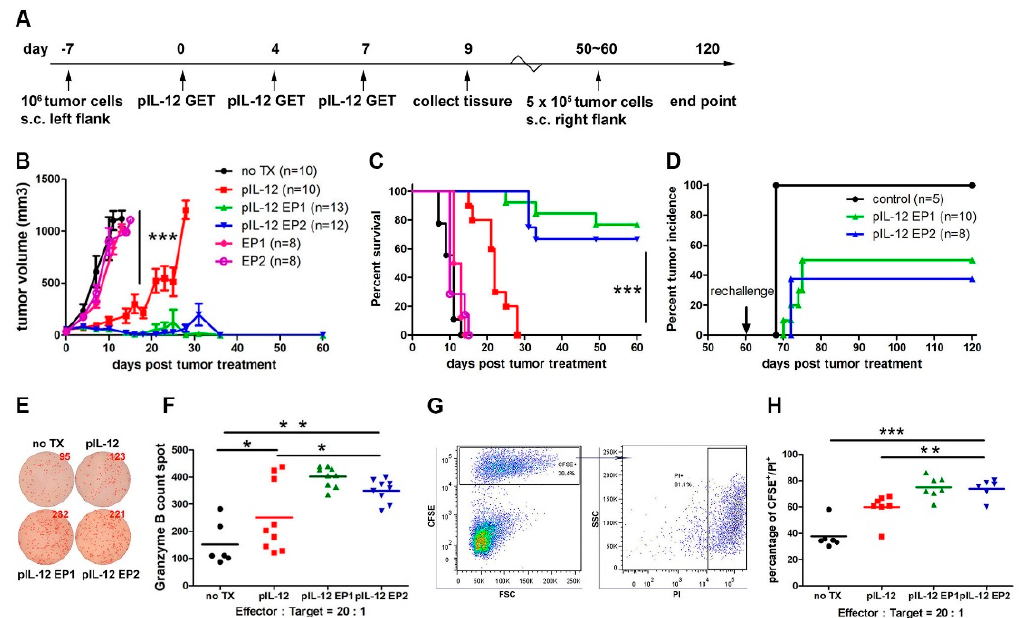
Figure 1. Antitumor efficacy in B16F10 tumor-bearing mice treated with IL-12 plasmid delivered by in vivo electroporation (pIL-12 GET) and protective immunity against tumor rechallenge. ( A ) Experimental scheme. On day-7, C57BL/6 mice were inoculated with B16F10 cells (1 × 10 6 /50 µ L, s.c in the left flank.). Tumor-bearing C57BL/6 mice were treated with pIL-12 GET on days 0, 4 and 7. Spleen and tumor tissues were collected on day 9. On day 60, long term surviving tumor-free mice were rechallenged by injection of B16F10 cells at half dose (5 × 10 5 /50 µ L). The end point time of experiment was day 120. ( B ) Tumor volume was monitored and recorded every 2–3 days until the tumor volume reached the end point. ( C ) Overall survival was determined throughout a 50-day time course. ( D ) Percentage of tumor incidence after rechallenge. ( E , F ) On day 9, splenocytes (1 × 10 5 ) from B16F10 tumor-bearing mice were incubated with B16F10 target cells for 48 h in 96-well plates in triplicate (200 μ L/well) at ratio of 20:1. Granzyme B spots counted in enzyme-linked immunospot (ELISPOT). ( G , H ) Splenocytes (1 × 10 6 ) from B16F10 tumor-bearing mice were incubated with carboxyfluorscein succinimidyl ester (CFSE) stained-B16F10 target cells in u-bottom tube in triplicate at ratio of 20:1 for 4 h. The cytotoxic activity was measured by flow cytometric analysis comparing CFSE + PI + cells